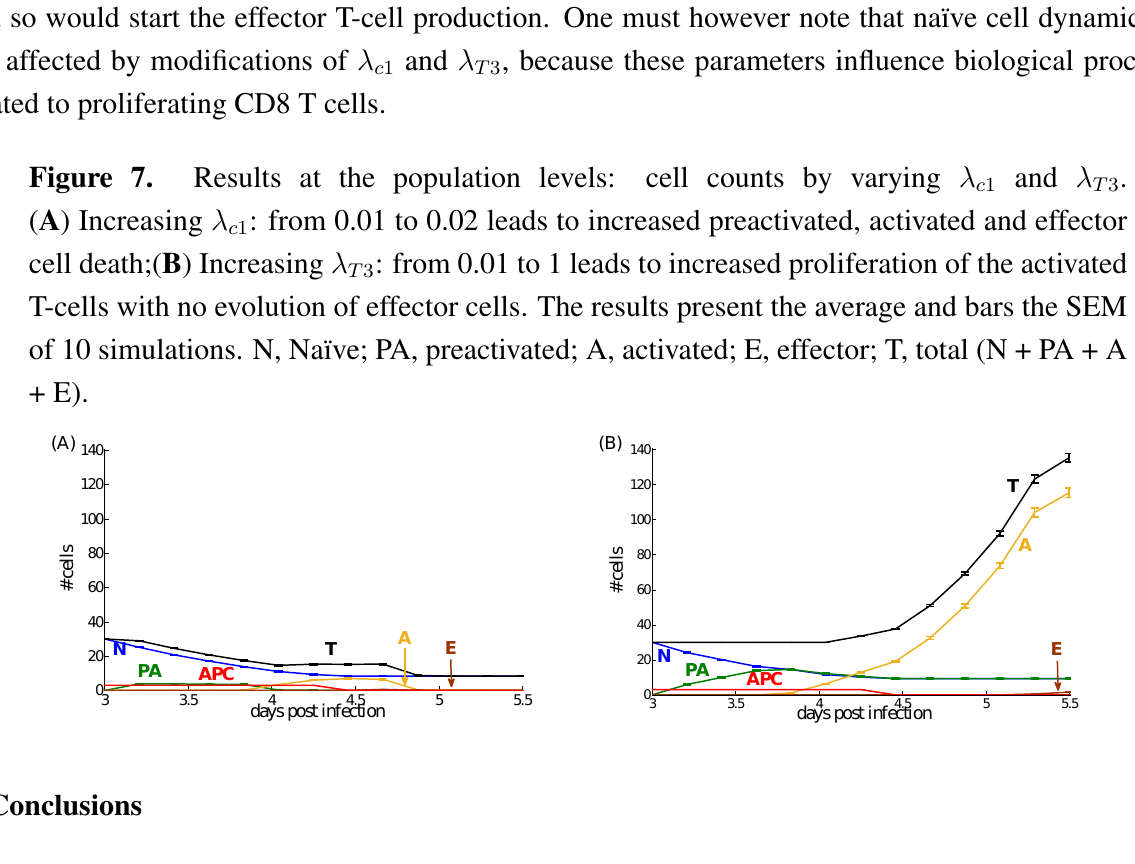
cell counts by varying λ